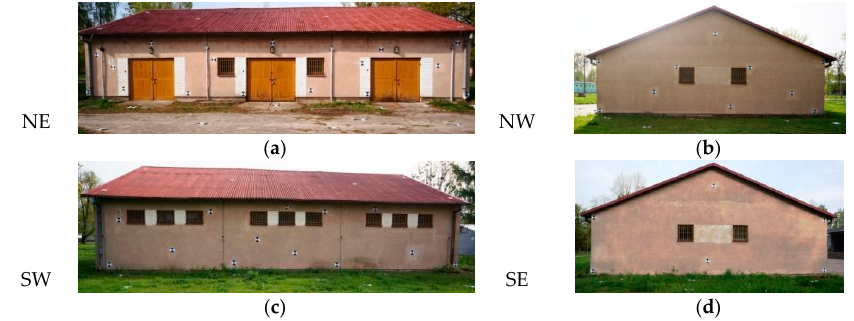
Figure 6. Photogrammetric network on the building walls and around the building. ( a ) Northeastern wall (NE); ( b ) Northwestern wall (NW); ( c ) Southwestern wall (SW); ( d ) Southestern wall (SE).